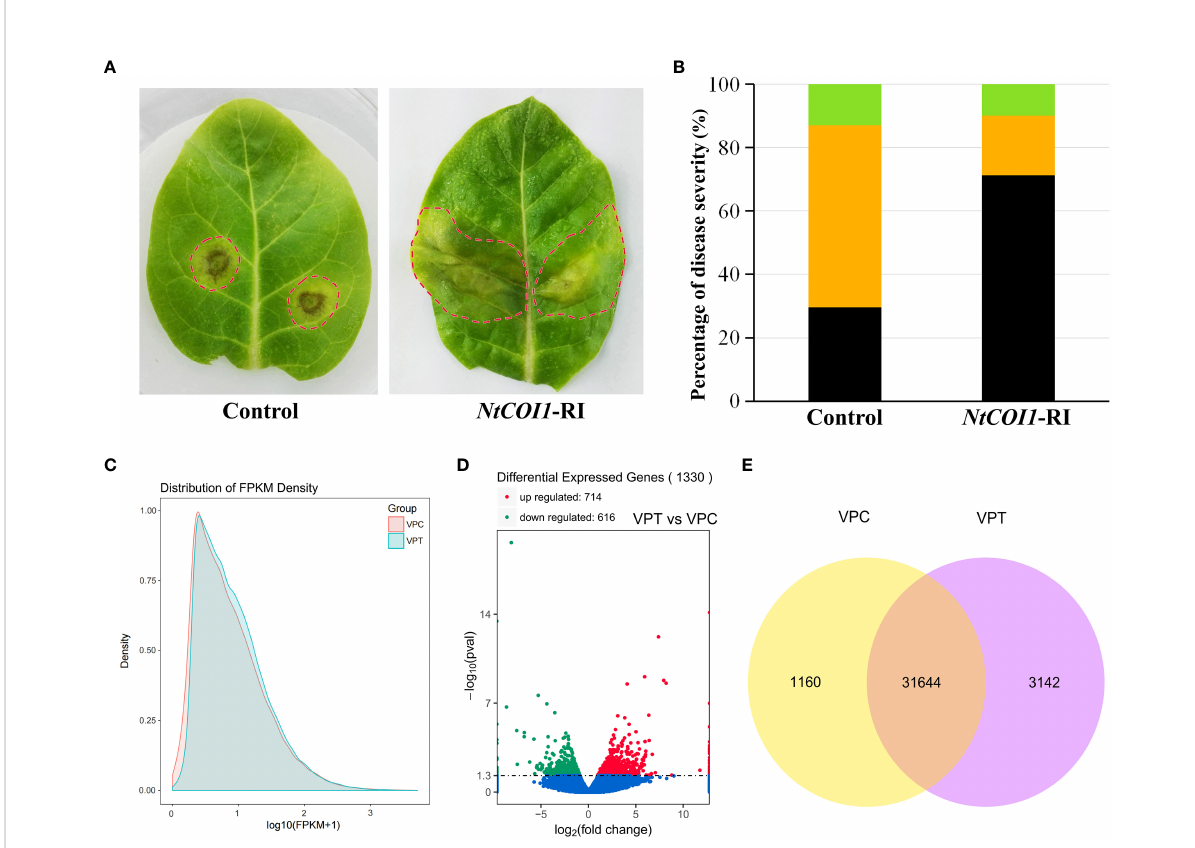
FIGURE 1 Responses of tobacco plants to P. nicotianae infection. (A) Representative symptoms of control and NtCOI1 -RI tobacco leaves infected by P. nicotianae . The leaf area with visible symptom was indicated with dashed-circle. (B) Percentiles of tobacco leaves with differential symptom severity. The black color indicates water-soaking symptom, the orange color indicates necrosis symptom, and the green color indicates no visible symptom. (C, D) The density distribution (C) , volcano plot (D) and Venn diagram (E) of the differentially expressed genes (DEGs) between control and NtCOI1 -RI plants after P. nicotianae infection. VPT indicates NtCOI1 -RI plants, and VPC indicates control